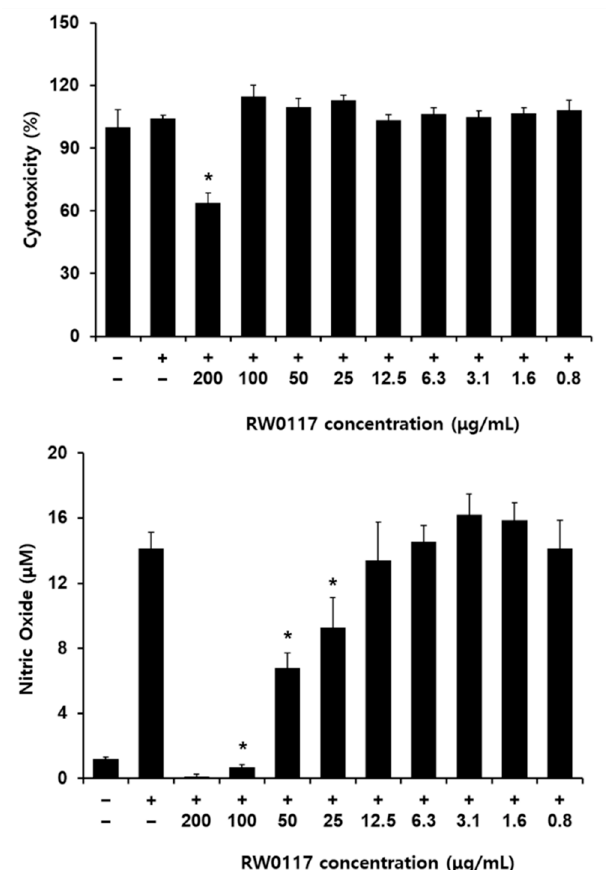
Figure 3. The effects of RW0117 on nitric oxide production in LPS-stimulated RAW264.7 cells; ( − ): vechicle group (0.1% DMSO-treated group), (+): positive control group (500 ng/mL of LPS treatment for 20 h). Cells were treated with RW0117 for 2 h and then incubated with LPS for 20 h. Results are expressed as mean ± SD of triplicate experiments. Statistical significance was determined using one-way analysis of variance (ANOVA) followed by Tukey’s post hoc test. * p < 0.001 vs. LPS treated group.